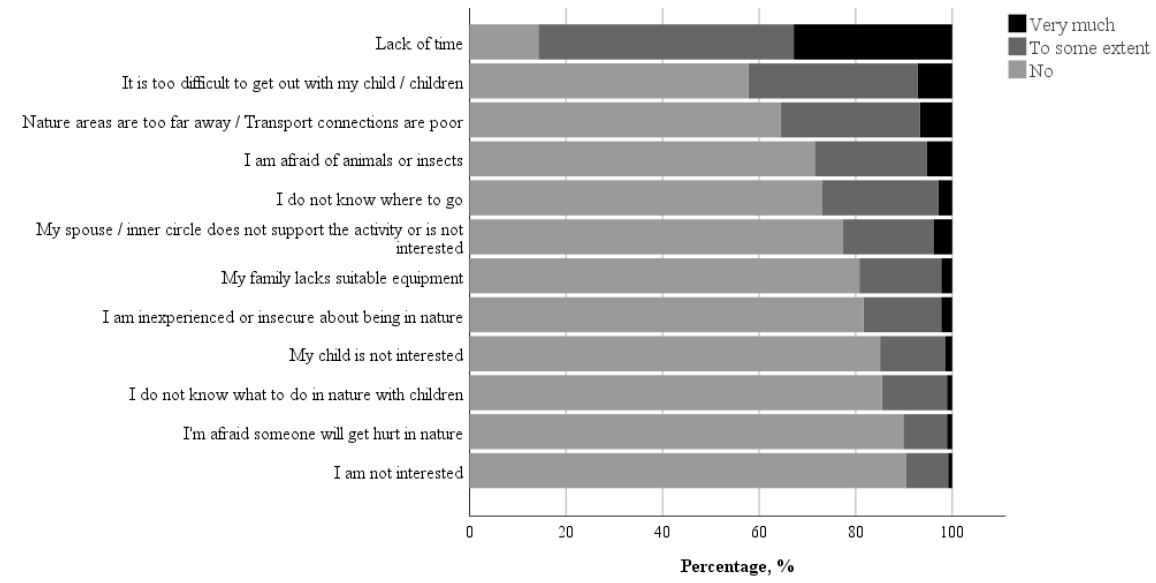
Figure 2. Perceived barriers to visiting nature as evaluated by parents in answer to the following question: “Do the following reasons prevent you from visiting nature with your child?” The data are presented as percentages of 12 items.